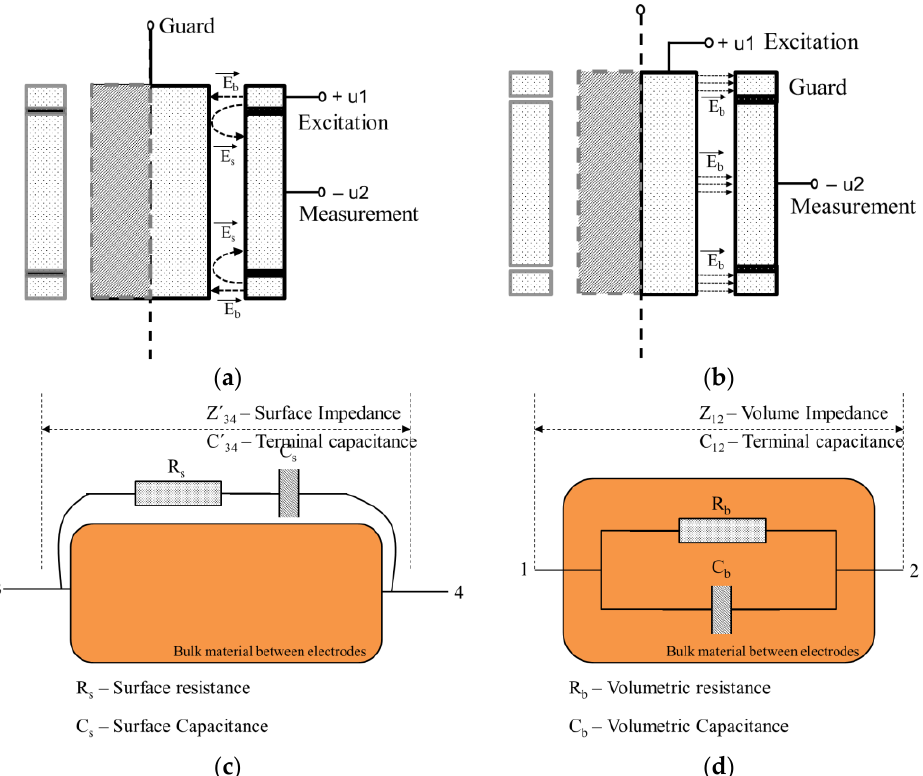
Figure 3. Measuring principle for recording the electrical properties of the chosen DBD reactor bed materials. ( a ) Surface parameter; ( b ) volume parameter; ( c ) RC circuit analogy of surface measurements after volume parameters guarded out; ( d ) RC circuit analogy of volume measurements with volumetric parameters guarded out.